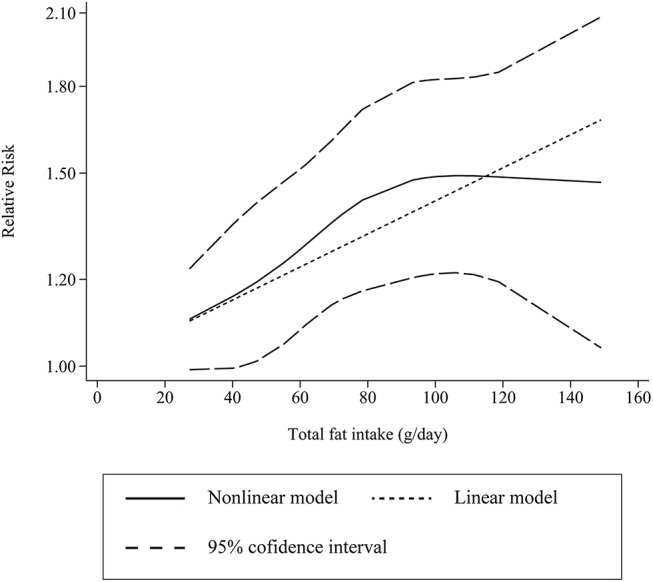
Dose-response relationship for total fat intake level and the RR of gastric cancer risk (P-nonlinearity = 0.50).